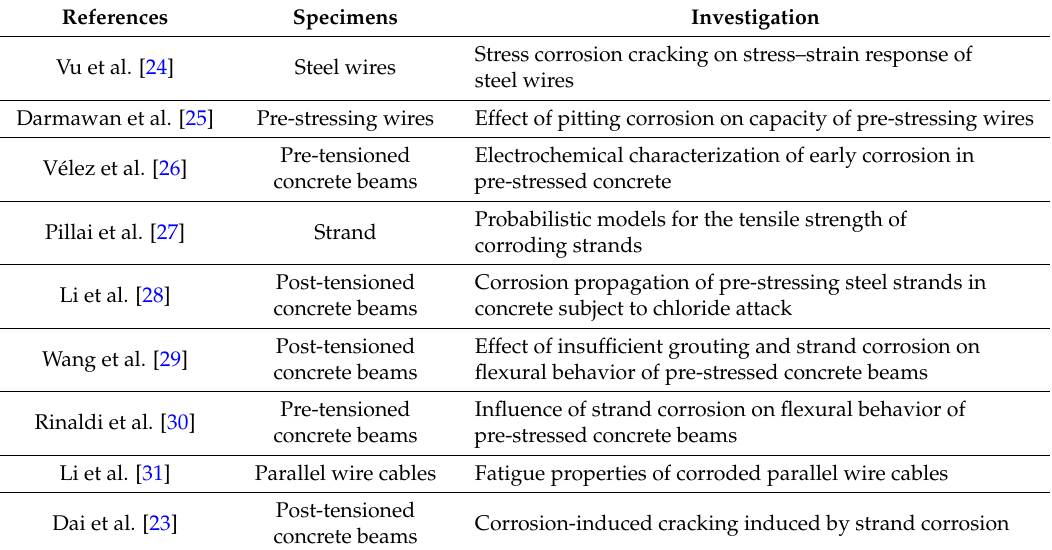
Table 1. Summary of studies on strand corrosion and crack